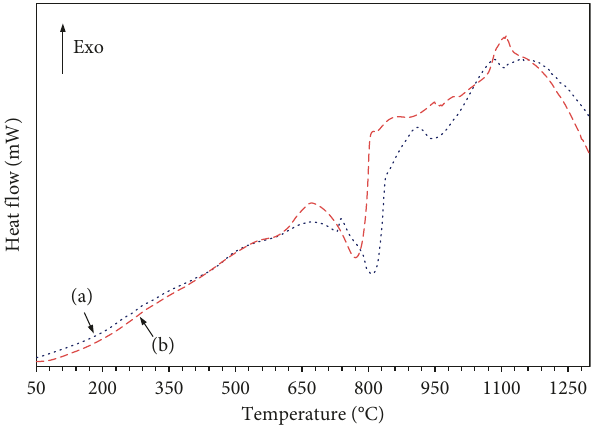
Figure 7: DSC measurements of duck eggshell+ A-TiO milled for 30min and (b) high-energy-milled for 30 min.